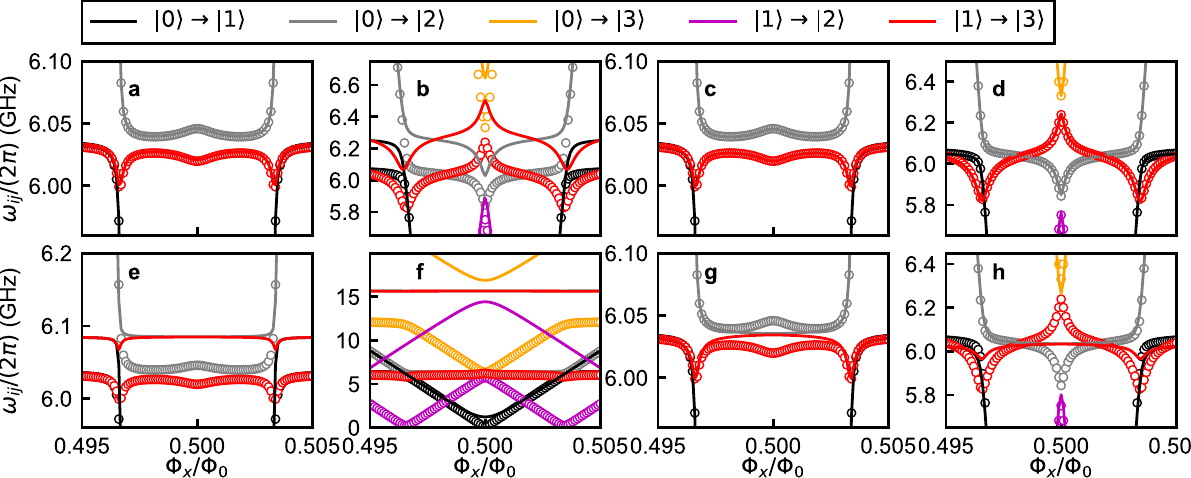
Figure 4. Transition frequencies of the qubit-oscillator circuit fitted with different approximate Hamiltonians. Numerically calculated transition frequencies from ˆ H circ are plotted as circles while the fitting spectra are plotted as lines. Two mutual inductance values, corresponding to different qubit-oscillator coupling strengths, are used: L c = 20 pH ( a , c , e , g ) and L c = 350 pH ( b , d , f , h ). The spectra are fitted with ˆ H R ( a – d ) and ˆ H ′ R ( e – h ). 6.033 GHz, ( a , b ) The parameters of ˆ H R are obtained from the relations described in Table 1: ω/( 2 π) = 0.424 GHz, and I 20 pH and ω/( 2 π) 1.240 GHz, g /( 2 π) 281.3 nA for L 6.272 GHz, � q /( 2 π) c = p = = = = 7.338 GHz, and I 350 pH. ( c , d ) The parameters 2.139 GHz, g /( 2 π) 282.5 nA for L � q /( 2 π) c = p = = = 2 π) 1.240 GHz, 6.033 GHz, � of ˆ H R are obtained by fitting the spectra of ˆ H circ to ˆ H R : ω/( 2 π) q /( = = 0.430 GHz, and I 20 pH and ω/( 2 π) 281.3 nA for L 2 π) 2.388 GHz, 6.064 GHz, � g /( 2 π) c = p = q /( = = = H 7.822 GHz, and I 350 pH. ( e , f ) The parameters of 282.9 nA for L g /( 2 π) c = p = ′ R are obtained from the ˆ = 2 π) 1.238 GHz, 6.085 GHz, � circuit parameters of ˆ H ′ circ in the similar way as in Table 1: ω/( 2 π) q /( = = 20 pH, and ω/( 2 π) 281.3 nA for L 2 π) 1.238 GHz, 15.66 GHz, � g ′ /( 2 π) 0.043 GHz, and I p c = q /( = = = = H 350 pH. ( g , h ) The parameters of 281.3 nA for L g ′ /( 2 π) 0.492 GHz, and I p c = ′ R are obtained by ˆ = = 0.089 GHz, and 2 π) 1.220 GHz, g /( 2 π) 6.035 GHz, � fitting the spectra of ˆ H ′ circ to ˆ H ′ R : ω/( 2 π) q /( = = = 20 pH and ω/( 2 π) 0.165 GHz, and 281.3 nA for L 2 π) 0.233 GHz, g /( 2 π) 6.034 GHz, � I p c = q /( = = = = 350 pH. Black, gray, orange, magenta, and red colors indicate transitions 281.4 nA for L 0 1 I p , c = | � → | � = 0 2 0 3 1 2 1 3 , , , and , | � → | � | � → | � | � → | � | � → | �